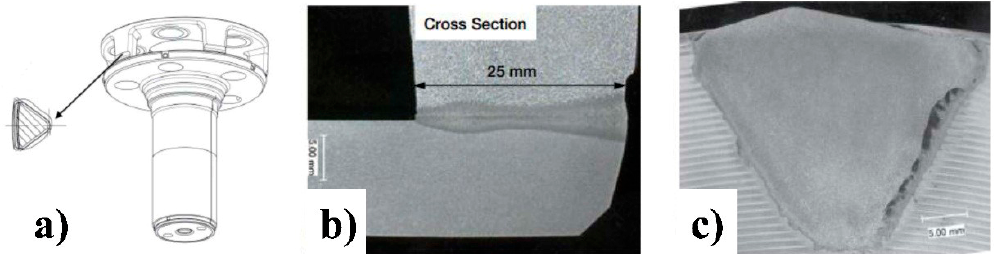
Figure 11. The planet wheel carrier welded by laser welding under vacuum ((laser power is 7.5 kW, welding speed is 0.42 m/min, defocus distance is − 5 mm, ambient pressure is 20 mbar-1). Reproduced with permission from [59], John Willey and Sons, 2015. ( a ) The schematic of planet wheel carrier, ( b ) Cross-section in stud center, ( c ) Longitudinal section through the weld.